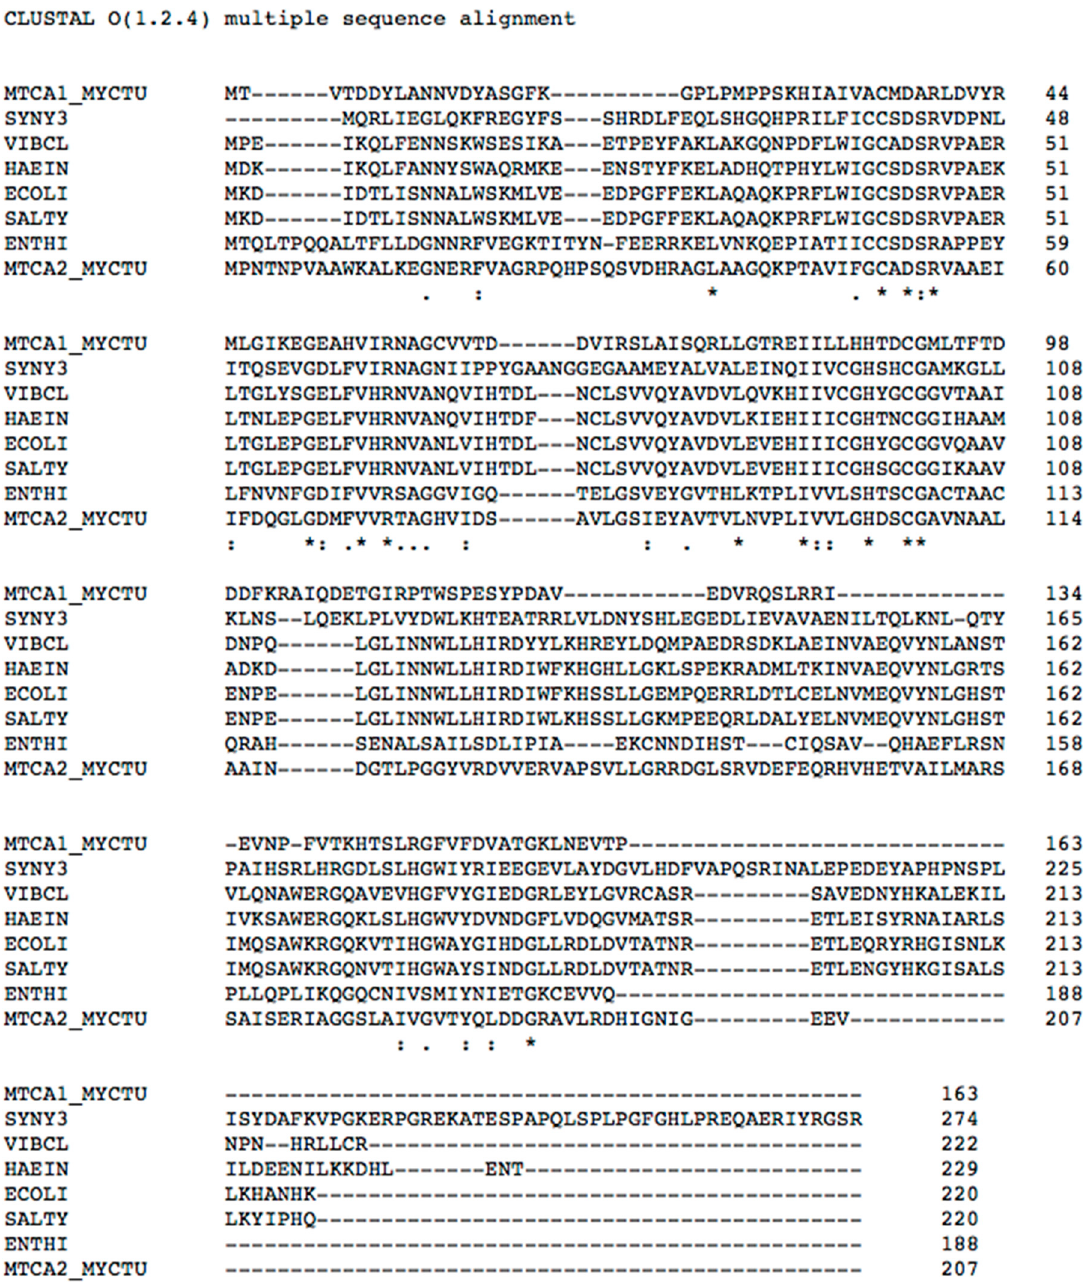
Figure 2. Multi-alignment of the amino acid sequences of the β -CAs from M. tuberculosis (isoform MTCA1_MYCTU), Synechocystis sp. (SYNY3), V. cholerae (VIBCL), H. influenzae (HAEIN), E. coli (ECOLI), S. typhimurium (SALTY), E. histolytica (ENTHI), and M. tuberculosis (isoform MTCA2_ MYCTU) [11,27–30]. Conserved amino acids depicted by an asterisk (*), semiconserved ones by (.) or (:). Table 1. Kinetic parameters for the CO 2 hydration reaction catalyzed by the human cytosolic isozymes hCA I and II ( α -class CAs) at 20 °C and pH 7.5 in 10 mM HEPES buffer and 20 mM Na 2 SO 4 , and the β -CA EhiCA form E. histolytica measured at 20 °C, pH 8.3 in 20 mM TRIS buffer and 20 mM NaClO 4 . Inhibition data with the clinically used sulfonamide acetazolamide (5-acetamido-1,3,4-thiadiazole-2- sulfonamide) are also provided [31].